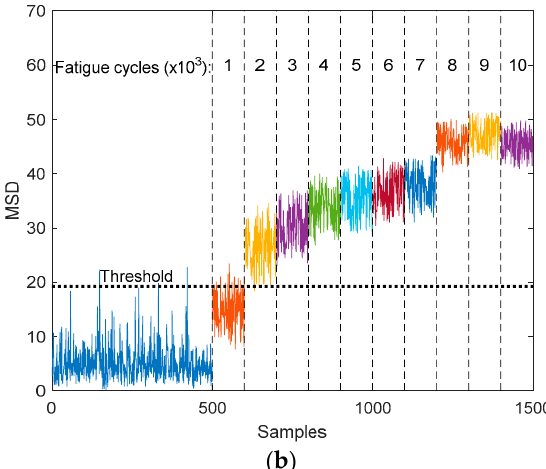
Figure 10. Outlier analysis results for specimen S_A with Level 2 contamination: ( a ) PDF of baseline MSD and ( b ) MSDs for different fatigue states.